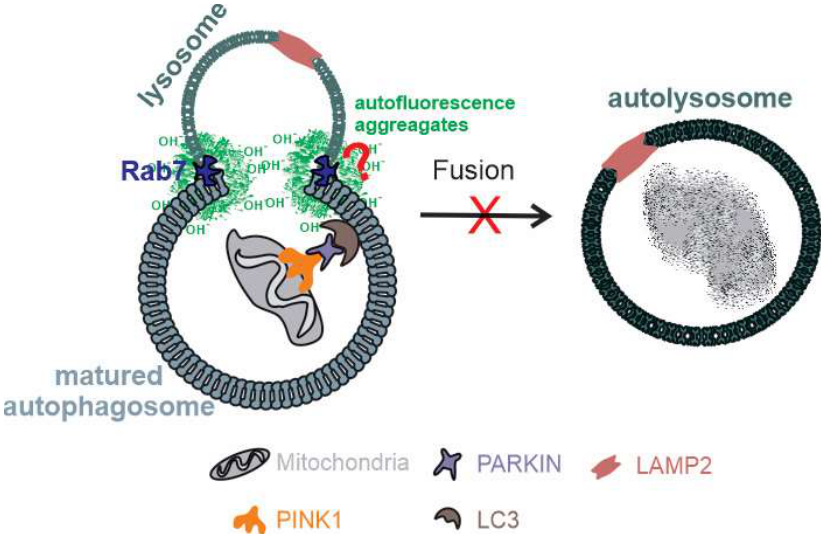
Figure 9. A schematic representation of disturbed selective autophagy in RPE cells of NFE2L2 / PGC-1